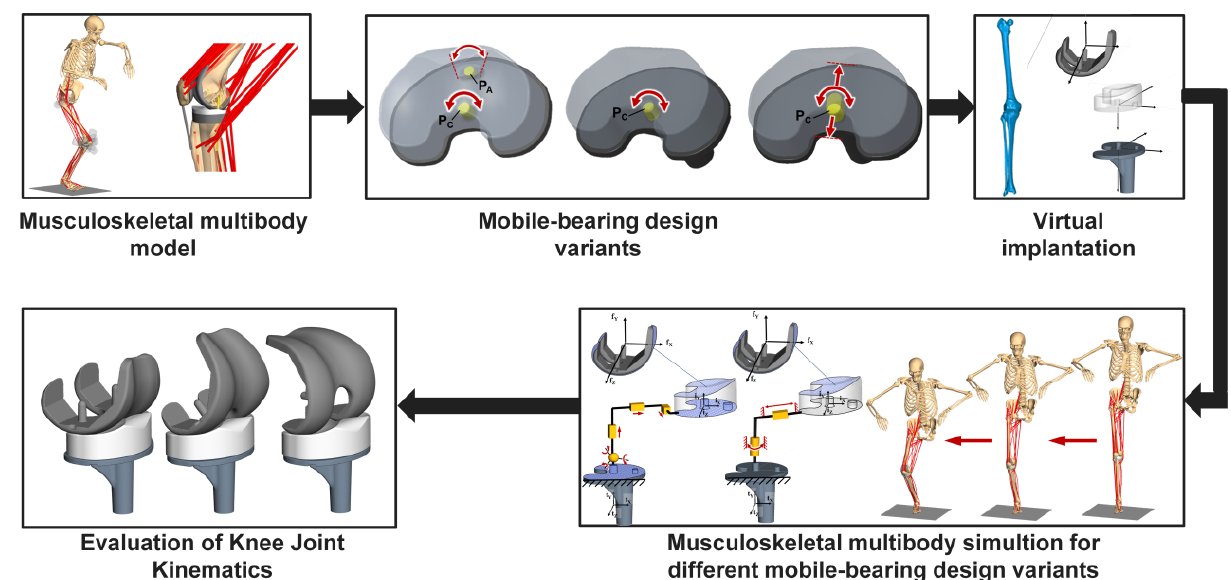
Figure 2. Illustration of the procedure to analyze different mobile-bearing design variants. Using a musculoskeletal multibody model of the lower right extremity, we implemented different mobile-bearing design variants within virtual implantation. These designs were analyzed within a dynamic musculoskeletal multibody simulation during the squat motion to evaluate the knee joint kinematics.